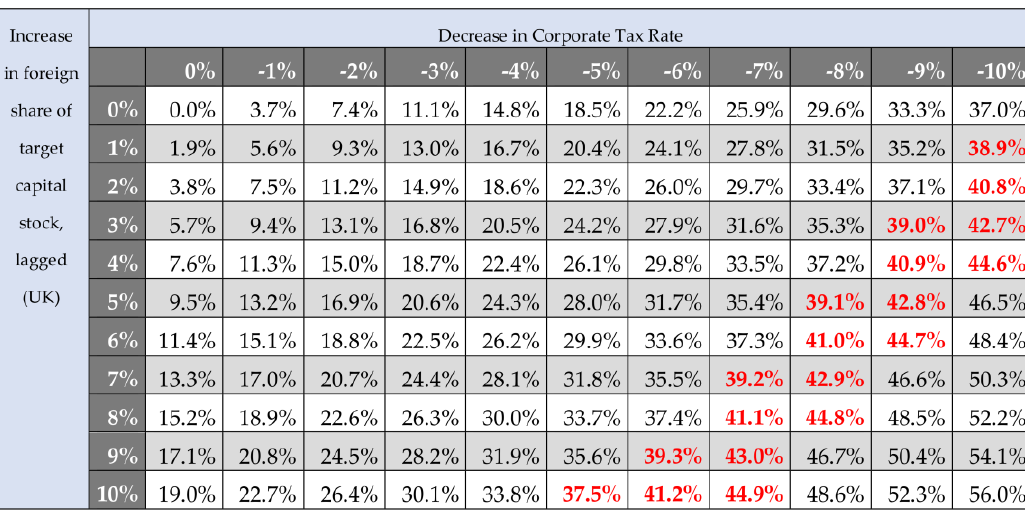
Figure 1. Scenario matrix for Corporate Tax and FDI Inward Stock Changes on FDI Inflows. Source: own calculations.